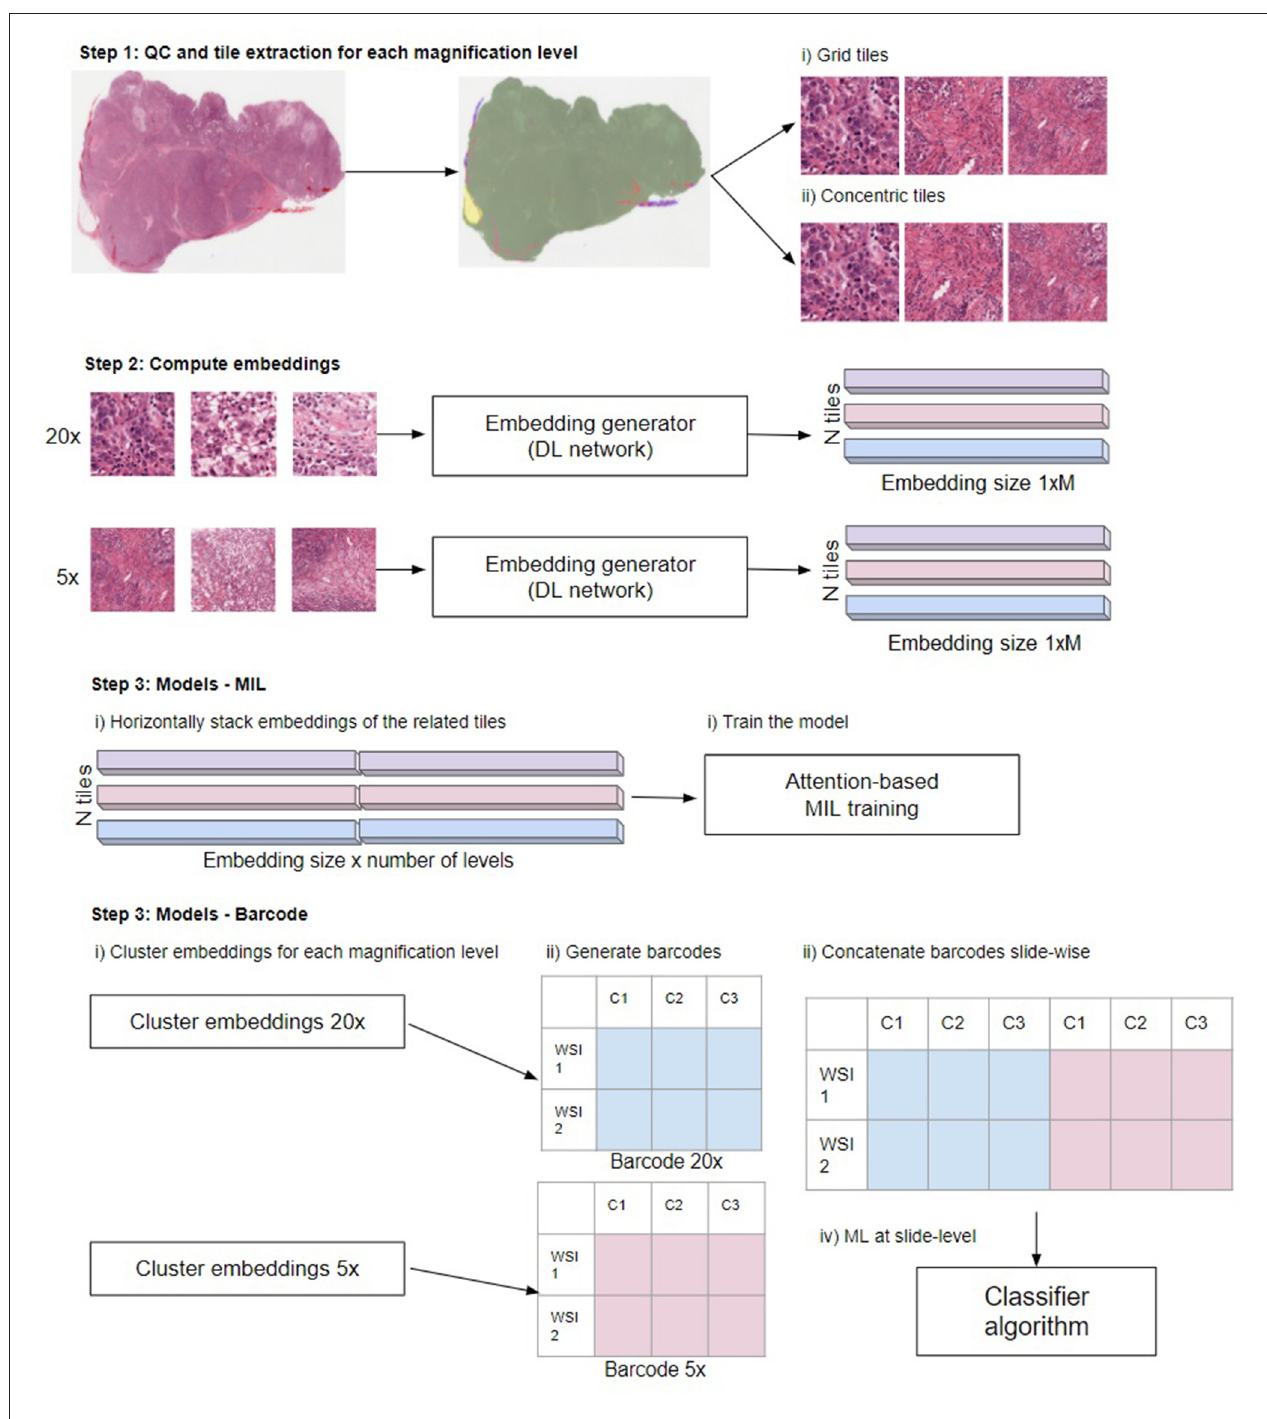
FIGURE 2 | Overview of the steps in the different multi-scale approaches used in this work. Step 1: Perform QC to extract in-focus tiles that contain tissue not covered by pen markers. Extract tiles for each magnification level using the grid and concentric approach. Step 2: Compute the embeddings from the tiles to obtain a 1xM representation for each tile, where M depends on the network (see main text “Compute embeddings”). Step 3, MIL: Train the model. Horizontally stack the embeddings of the related tiles. When using grid tiles, the same embedding at lower magnifications is duplicated and linked with different embeddings at higher magnification. Then, we provide the stacked embeddings as the input to the model. Step 3, barcode method: first cluster the embeddings for each magnification level. Subsequently, generate the barcodes (see reference 4 for details) and slide-wise concatenate the barcodes across magnifications. Finally, the thus created barcodes are used as input to a classifier: Illustration in Step 3 modified from Gueréndel et al. (4).